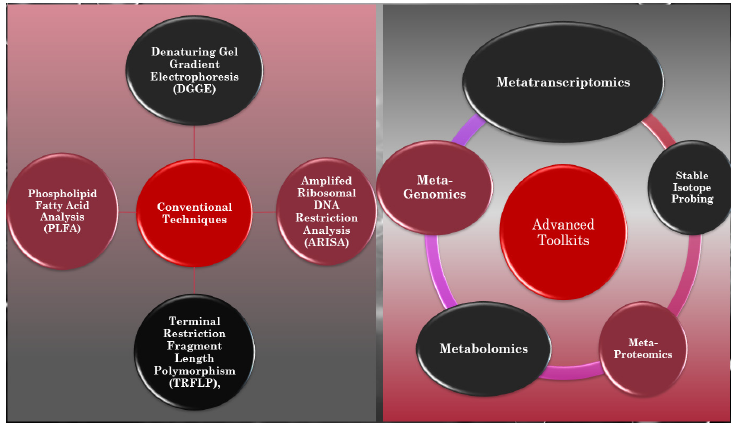
Figure 3. Techniques for unveiling the black box of soil.